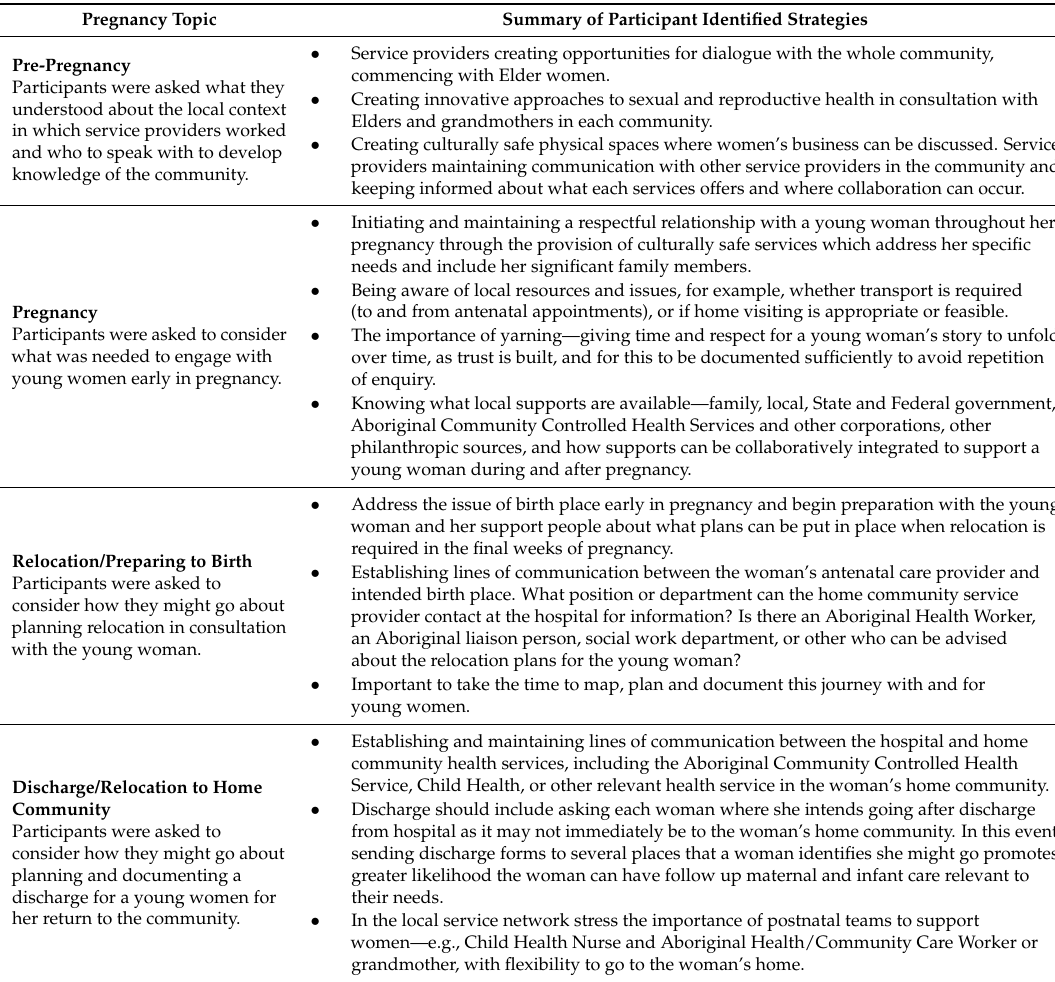
Table 1. Practical strategies to support Aboriginal adolescents during their pregnancy journey. Pregnancy Topic Summary of Participant Identified